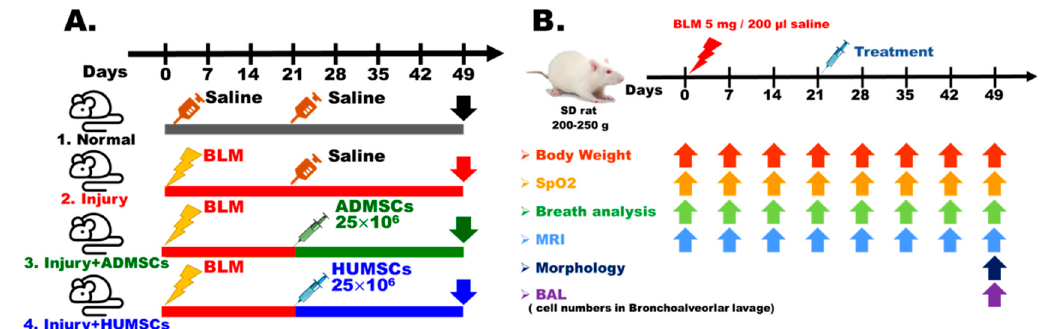
Figure 7. Scheme of experimental procedures and animal grouping. The rats were divided into four groups ( A ). Day 0 was defined as the day that BLM was administrated to the rats. HUMSCs or ADMSCs were delivered on Day 21 after BLM injection. Rats were sacrificed on Day 49 post-BLM injury ( B ).